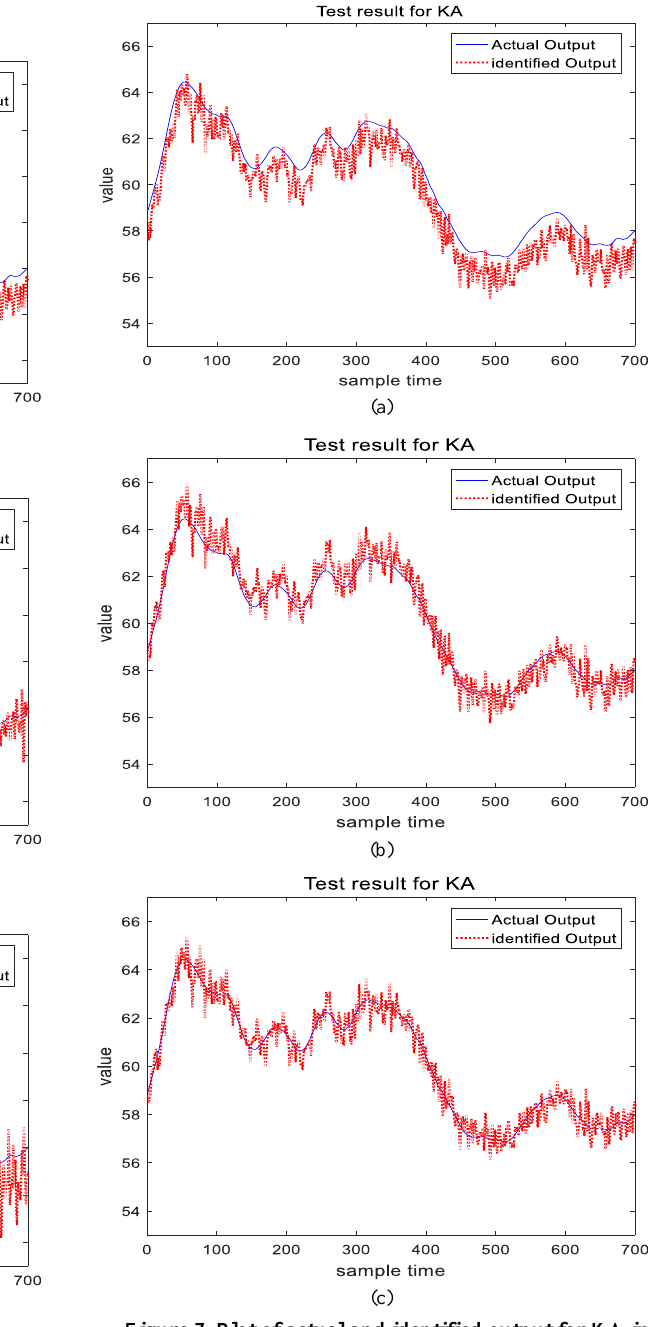
Figure 6. Plot of the actual and identified output for KA in case 𝛔 𝐓𝐫𝐚𝐢𝐧 =0.7 and (a) 𝛔 𝐓𝐞𝐬𝐭 =0.7 (b) 𝛔 𝐓𝐞𝐬𝐭 =1 (c) 𝛔 𝐓𝐞𝐬𝐭 =1.5